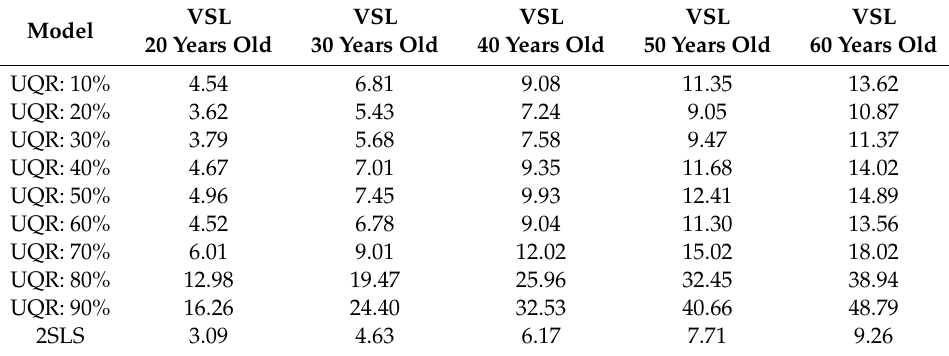
Table 5. The estimated value of statistical life by wage and age (million